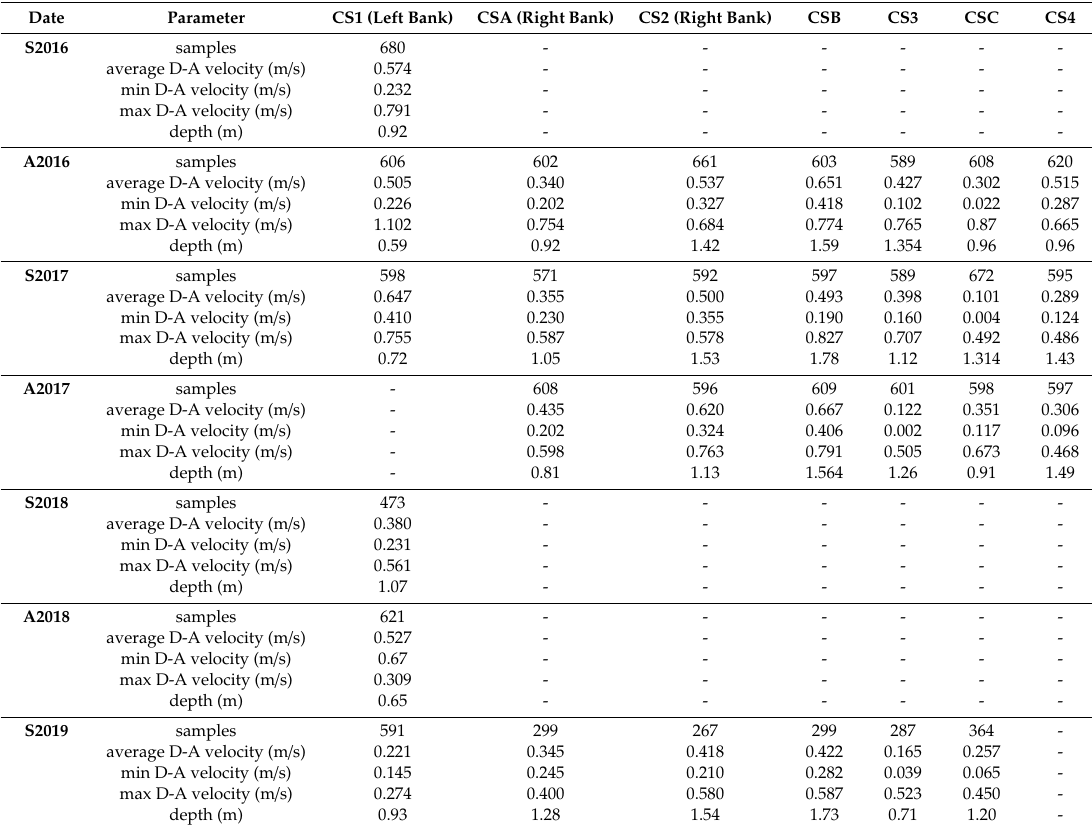
Table 2. The basic flow characteristics of each of the analyzed open-channel low measurement from their measurement location (see Figures 1 and 2) within cross-sections (CS). The average, minimum, and maximum values of depth-averaged (D-A) velocities were defined. During open channel conditions, the measurement of CS1 was always conducted on the left bank side of the mid-channel bar, and the measurement of CSA and CS2 on the right bank side of the mid-channel